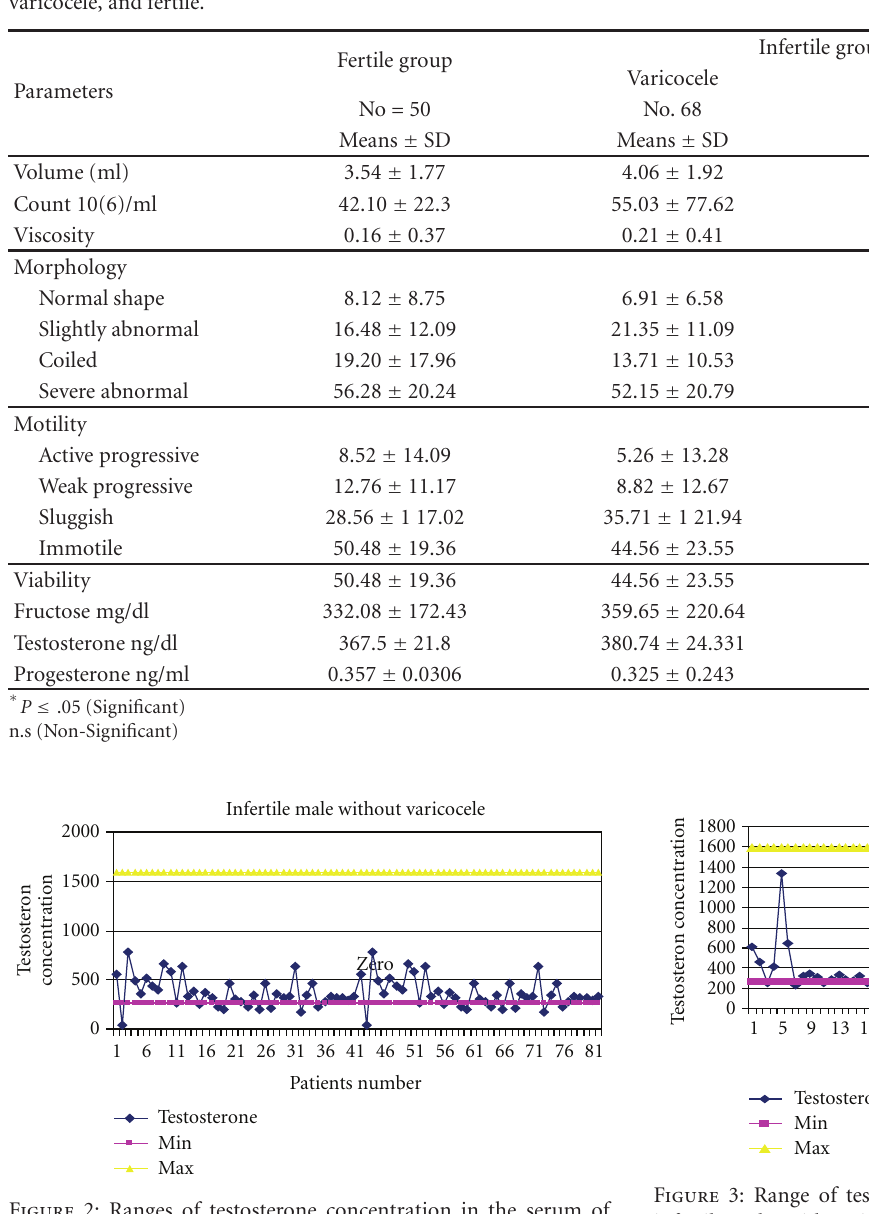
Table 1: A comparison between Sperm parameters, fructose level, steroid hormones among infertile males with varicocele, without varicocele, and fertile.